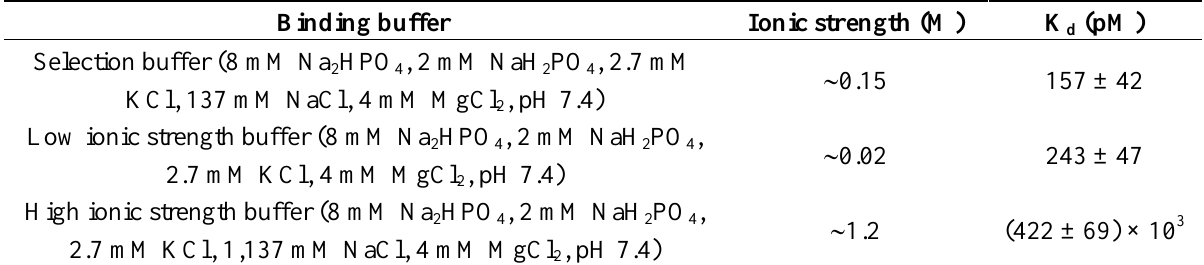
Table 1. Dissociation constants of the aptamer R15/19 binding to AChE in different binding buffers. The K values were obtained using ELONA. d